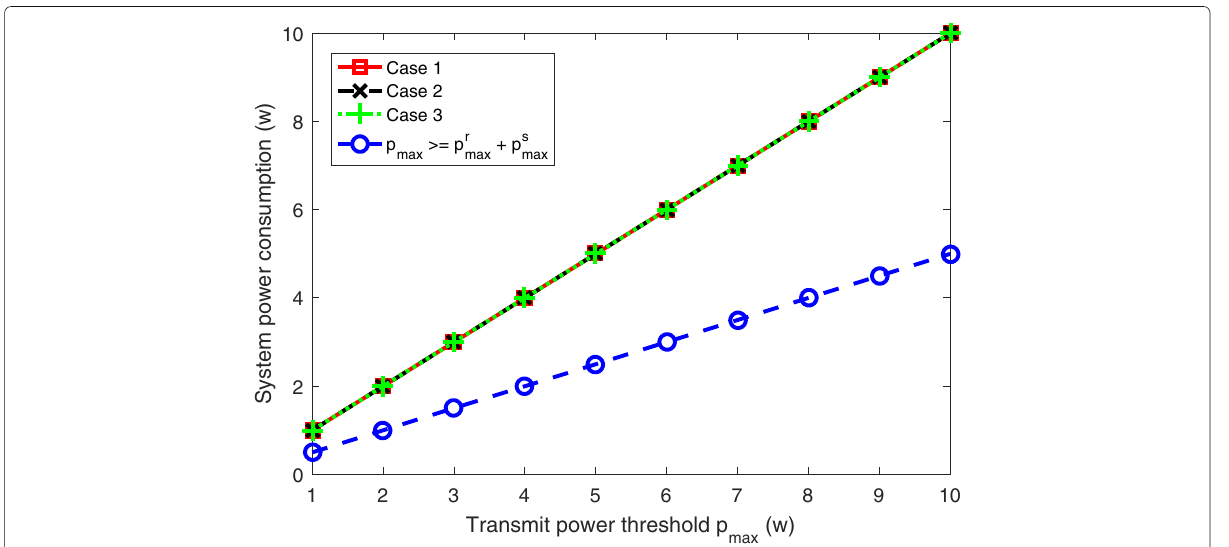
(cid:8) (cid:7) i.e., p max ≥ p s max + p r max